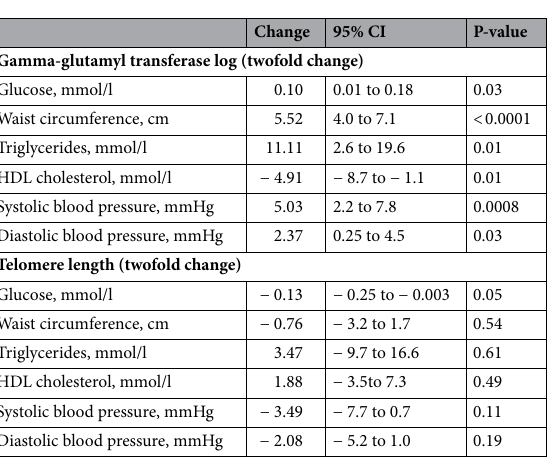
Table 2. Gamma-glutamyl transferase and telomere length in association with risk markers of cardiometabolic syndrome. Adjusted for age.